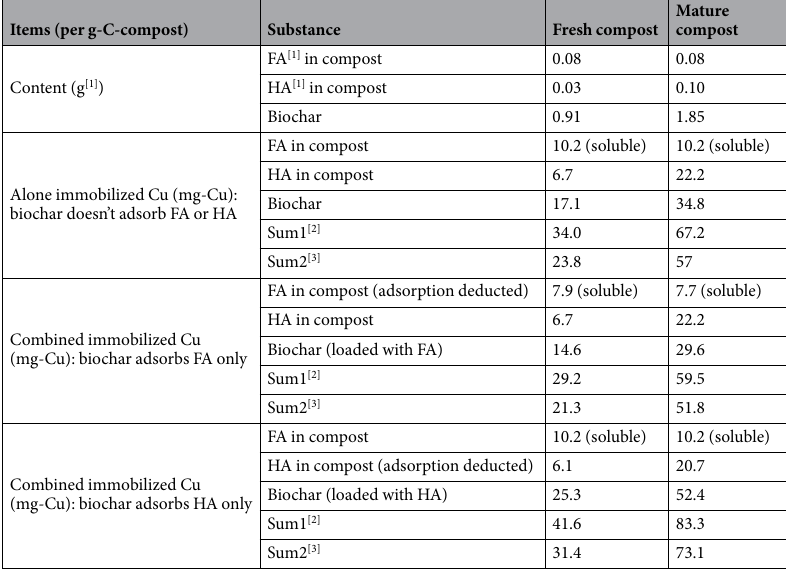
Table 4. Potentially amounts of immobilized Cu 2 + in fresh and mature compost. [1] For HA and FA, g represents g-C. [2] Sum1 means the sum of Cu 2 + immobilized by FA, HA and biochar. [3] Sum2 means the sum of Cu 2